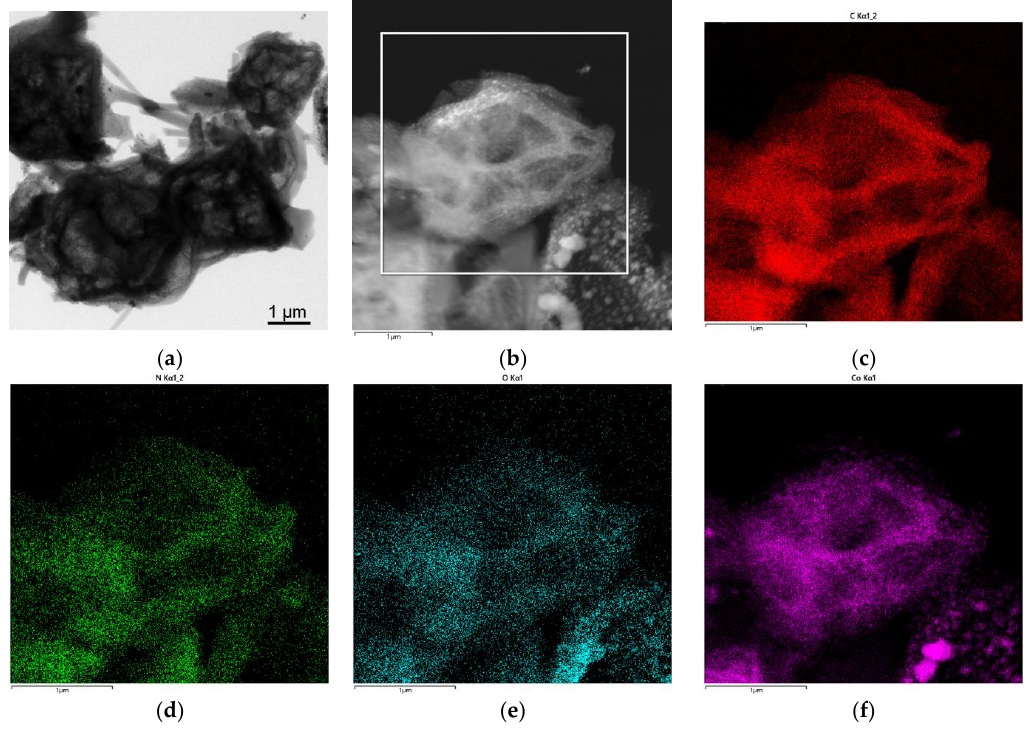
Figure 4. ( a ) TEM image of ZP600; ( b – f ) elemental mapping revealing the elemental distribution of C, N, O and Co in ZP600.